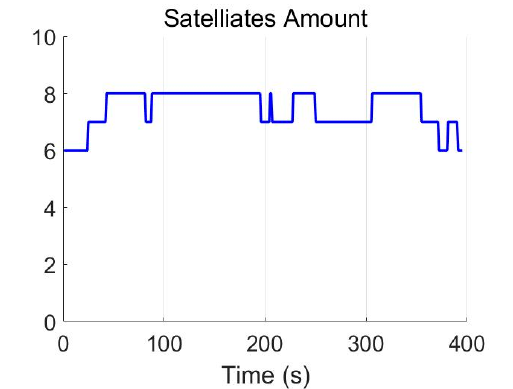
Figure 4. Satellite amount.